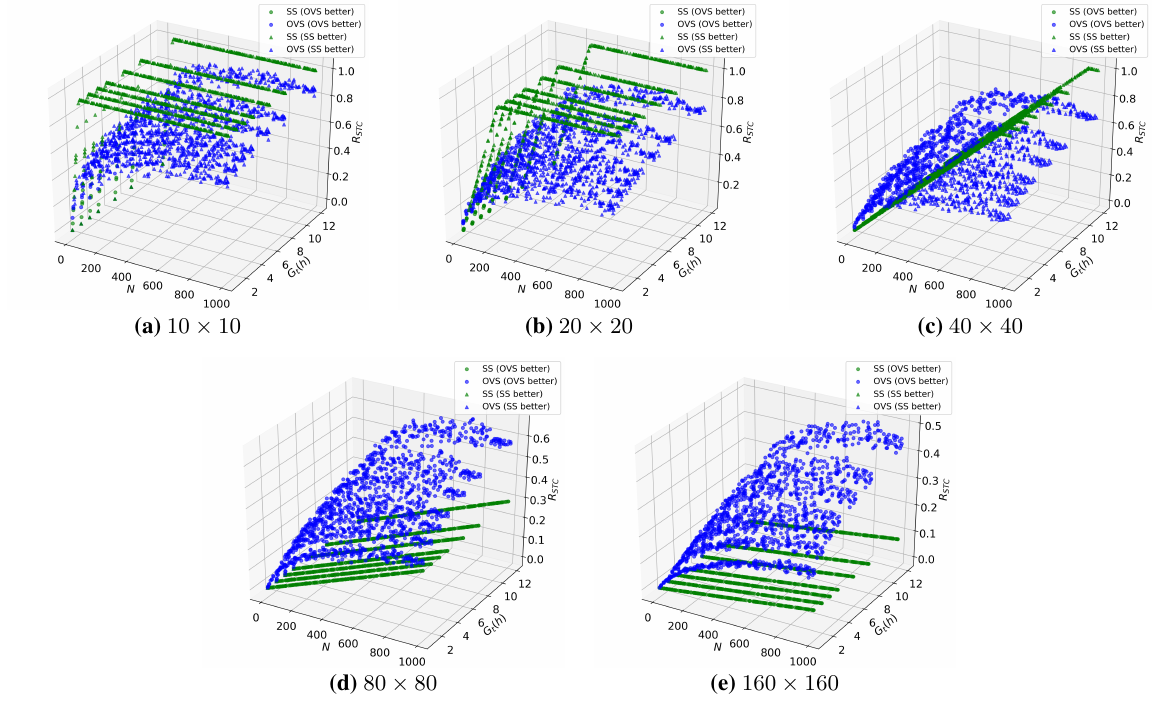
Figure 4. The ratio of spatio-temporal coverage in stationary and opportunistic vehicular sensing for various